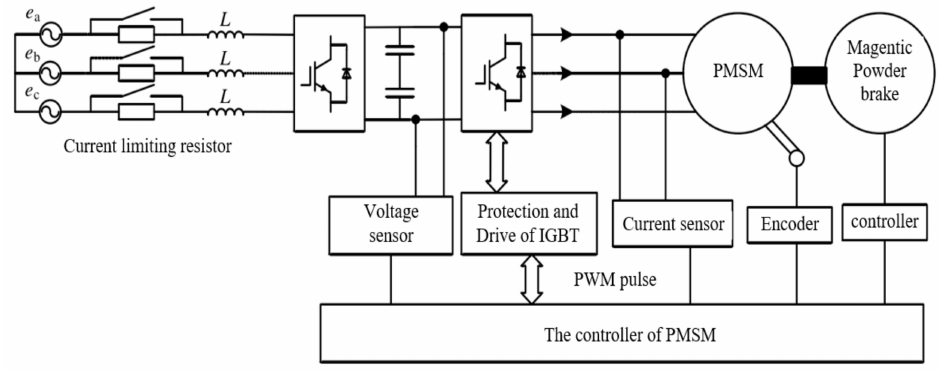
Figure 4. Structure of the PMSM traction experiment